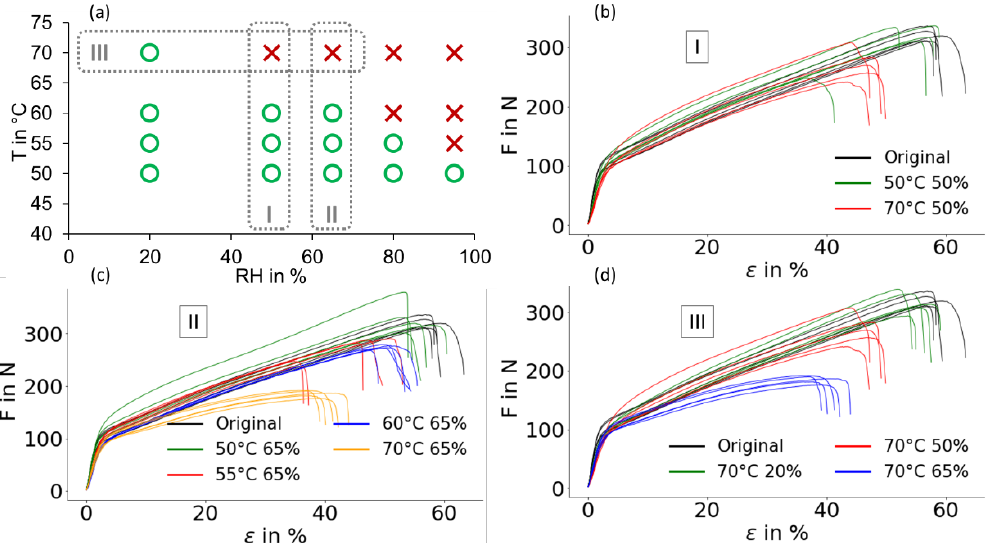
Figure 5. ( a ) Diagram of the apparent stability of nonwoven NW-L in terms of RH and aging temperature (showing conditions which correspond to mechanically stable (green circles) and mechanically weakened/degraded (red crosses) samples after 7 days of treatment). ( b – d ) Exemplary stress–strain curves of artificially aged nonwovens at indicated conditions, which are grouped in ( I – III ), as indicated by respective rectangles in the diagram.